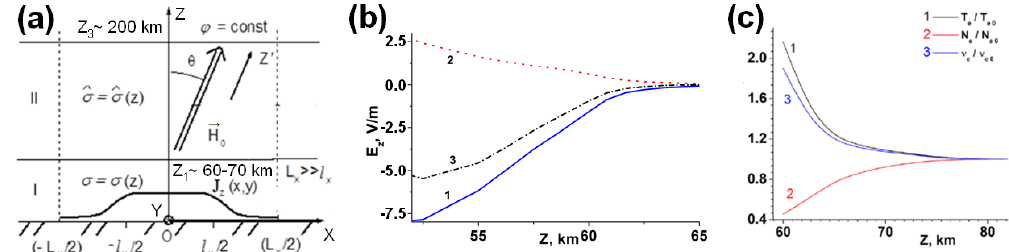
Figure 12. Modification of the ionosphere by the electric field of seismogenic origin based on the theoretical model (Rapoport et al., 2006). (a) Geometry of the model (Rapoport et al., 2006) for the determination of the electric field excited by the seismogenic current source J z (x,y) and penetrated into the ionosphere with isotropic (I) and anisotropic (II) regions of the “atmosphere–ionosphere” system. (b) Electric field in the mesosphere in the presence of the seismogenic current sources only in the mesosphere (1), in the lower atmosphere (2), and both in the mesosphere and in the lower atmosphere (3). (c) Relative perturbations caused by the seismogenic electric field, normalized on the corresponding steady-state values in the absence of the perturbing electric field, denoted by the index “0”, electron temperature ( T e /T e0 ), electron concentration ( N e /N e0 ) and electron collision frequency ( ν e /ν e0 ).